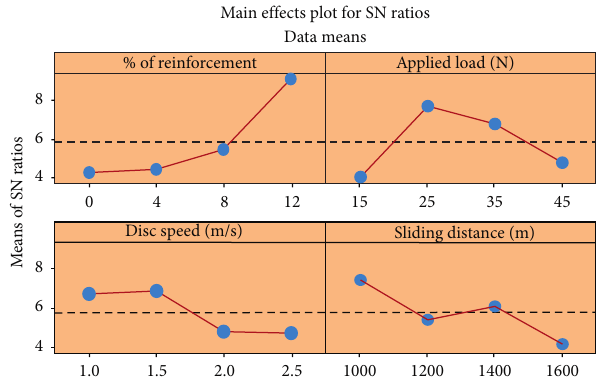
Figure 6: Main effects plot for S/N ratios (wear test).